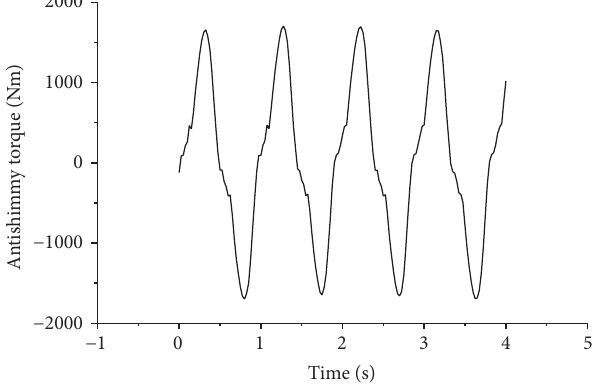
Figure 33: Antishimmy torque produced by antishimmy valves (2)